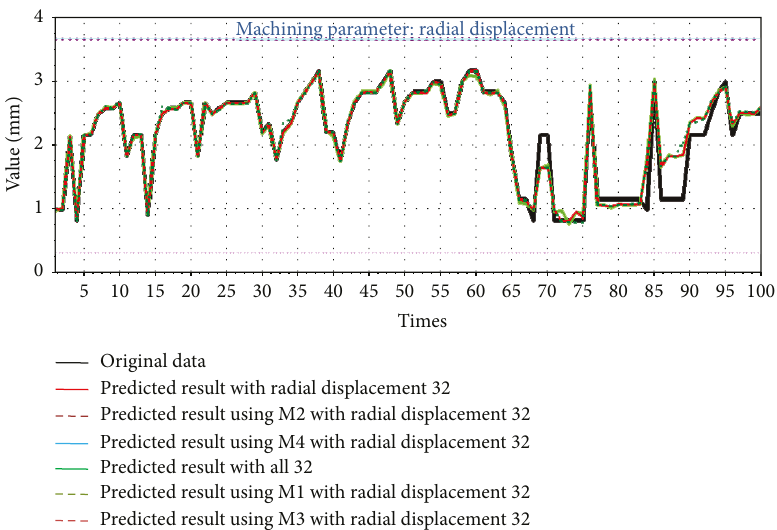
Figure 21: Predicted results of radial displacement of grinding